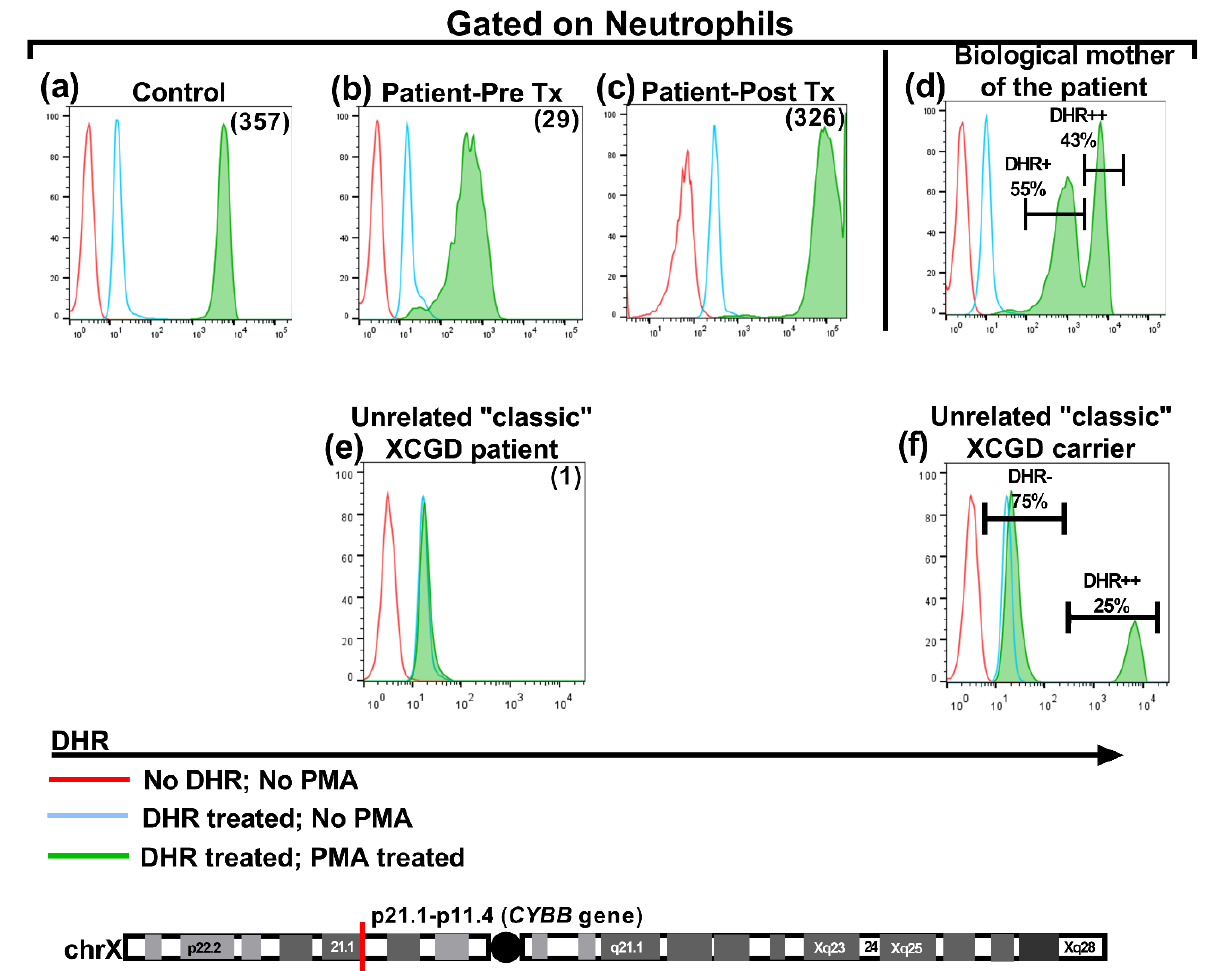
Figure 3. Assessment of neutrophil oxidative burst activity by flow cytometry. Three aliquots of whole blood from each donor were utilized to evaluate neutrophil oxidative burst activity. The first aliquot was left untreated. The second aliquot was labeled with dihydrorhodamine (DHR) and left unstimulated. The third aliquot was labeled with DHR and stimulated with phorbol 12-myristate 13-acetate (PMA) to induce neutrophil oxidative burst activity. The numerical values listed in parentheses in the overlaid histogram plots depict the neutrophil oxidative index (NOI), which is derived by dividing the median fluorescence intensity (MFI) of Rhodamine 123 observed in the PMA- stimulated tube (third aliquot) by the MFI of DHR measured in the second aliquot (unstimulated tube) (normal NOI >30). The DHR fluorescence patterns for the healthy control ( a ) and the patient sample pre- and post-stem cell transplant ( b , c ) are displayed. The DHR fluorescence in the biological mother’s sample ( d ) displays a “variant” bimodal distribution XCGD carrier pattern on account of the hypomorphic CYBB variant and random inactivation of the X-chromosome (lyonization). The frequencies of the maternal neutrophils harboring the normal (wild-type) and variant (mutated) CYBB genes are listed adjacent to the appropriate histogram peaks (DHR++ and DHR+). As a point of reference, the DHR fluorescence patterns from an unrelated case of “classic” XCGD ( e ) and a “classic” XCGD carrier ( f ) are also displayed. The frequencies of the neutrophils harboring the normal (wild-type) and mutated CYBB gene for the classic XCGD carrier are listed adjacent to the appropriate histogram peaks (DHR++ and DHR-) Tx: transplant.